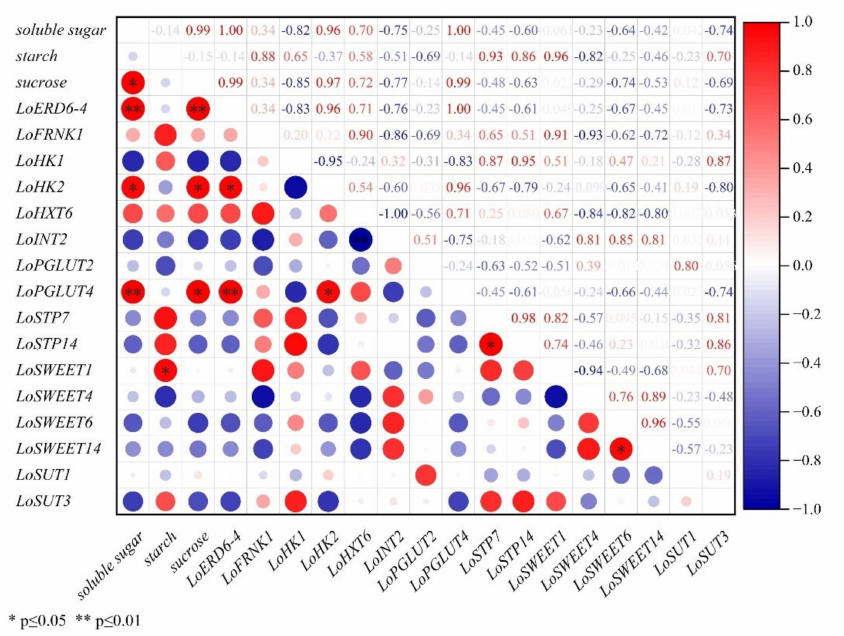
Figure 7. Correlation plot between sugar content and expression levels of ST genes during the assimilates transport in stems.